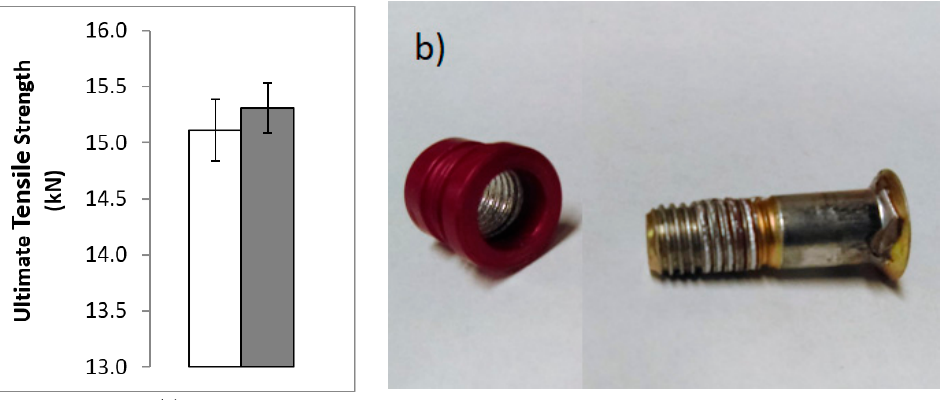
Figure 6. ( a ) Average static tensile strength of fasteners: Baseline open symbol, collar replacement filled symbol (error bars represent ±1 standard deviation); and ( b ) collar failure of fastener assembly.